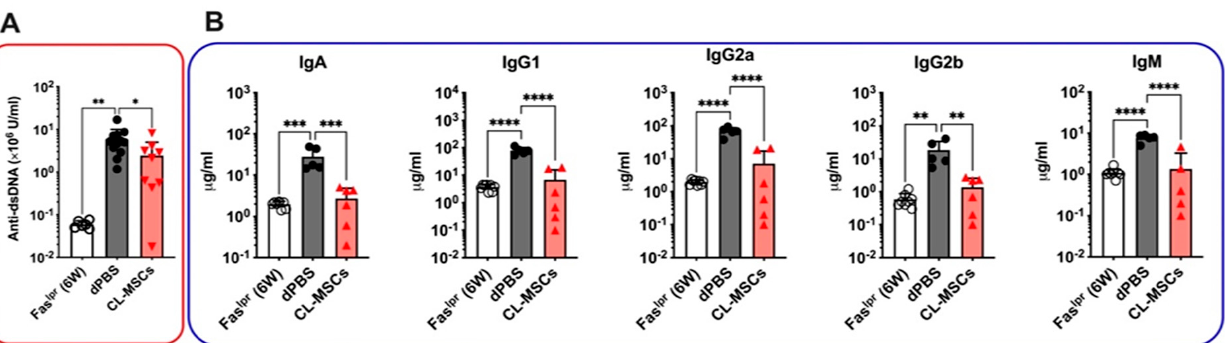
Figure 3. Both anti-dsDNA and isotype antibodies were reduced by CL-MSCs treatment: ( A ) Anti- dsDNA antibody changes in Fas lpr mice treated with dPBS (n = 9) and CL-MSCs (n = 10) at three weeks PT. Six-week-old Fas lpr mice (n = 12) were used as pre-onset control. ( B ) Isotype antibody changes in Fas lpr mice treated with dPBS (n = 5) and CL-MSCs (n = 6) at three weeks PT. Six-week- old Fas lpr mice (n = 8) were used as a pre-onset control. Results were expressed as mean ± SD. For multiple comparisons, the significance was defined as * p < 0.025; ** p < 0.005; *** p < 0.0005; **** p <